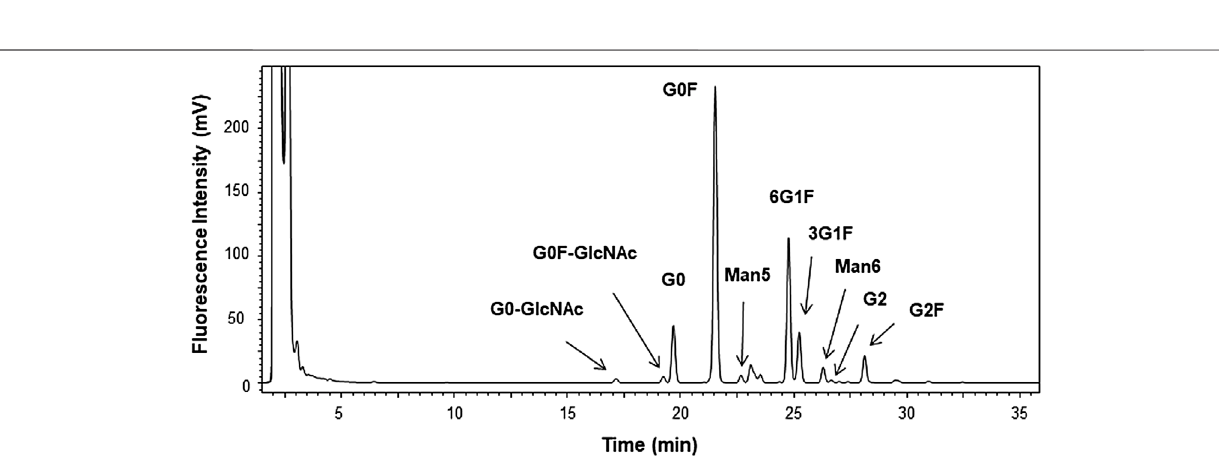
FIGURE 6 | Chromatogram of 2-aminobenzamide – derivatized glycan by liquid chromatography – fl uorescent detection (LC-FL) performed as glycan mapping. Glycan was released using peptide N -glycosidase F from the candidate reference material (RM). Peaks are assigned for 10 of the peaks with greater than 0.1% in the relative peak area ratio. The relative area ratios are summarized in Supplementary Table S4